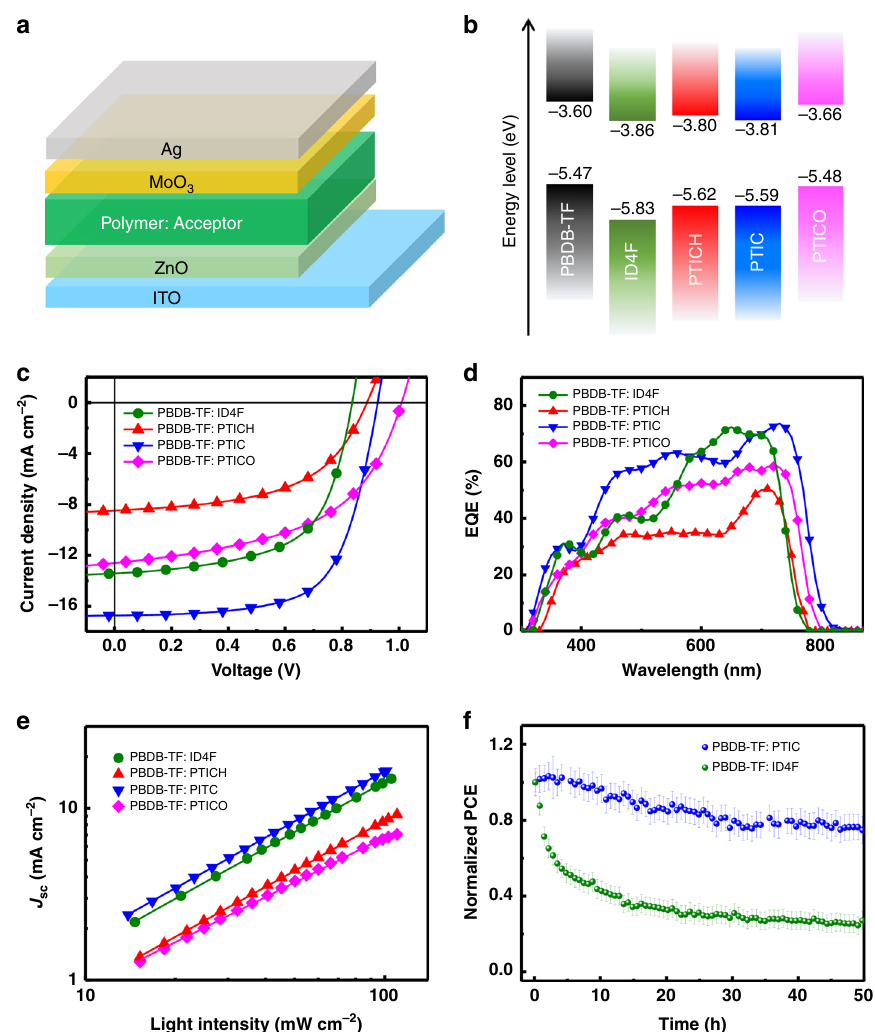
Fig. 3 Energy levels and photovoltaic performance. a Inverted OSC device architecture. b Energy levels for different active components. c The J – V characteristics and d EQE spectra of OSCs under AM 1.5 G illumination (100 mW cm – 2 ). e J SC versus light intensity of the OSCs. f Stabilities of encapsulated devices under continuous illumination of a metal halide lamp without UV fi ltration. The error bars represent the standard deviation from four